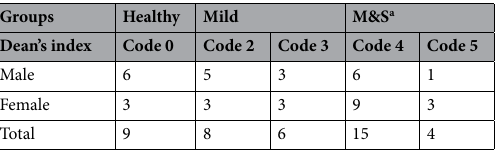
Table 2. Distribution of individuals by sex and Dean’s index. a M&S represent moderate and severe.